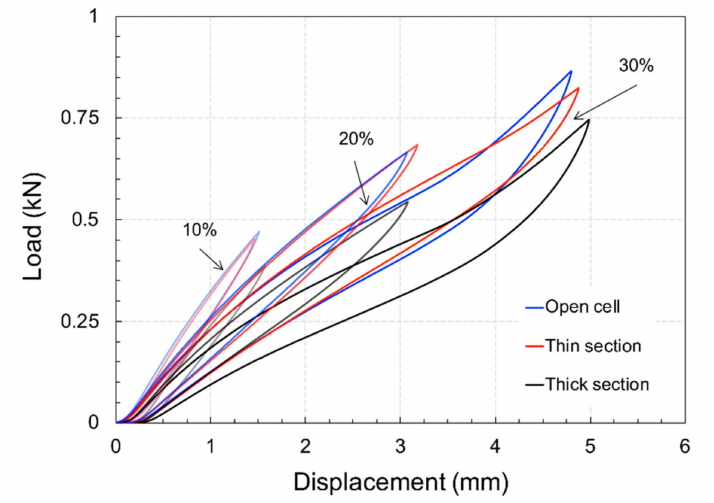
Figure 10. Experimental load-displacement